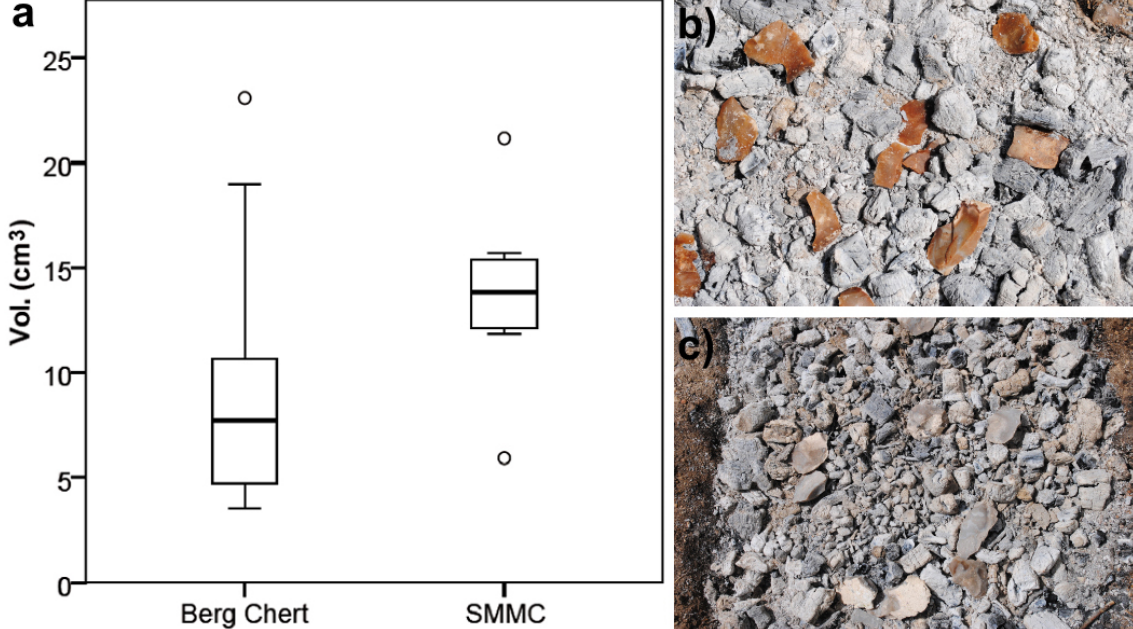
Figure 12. a) Box plots showing volume of blanks employed to test effects of throwing blanks directly to